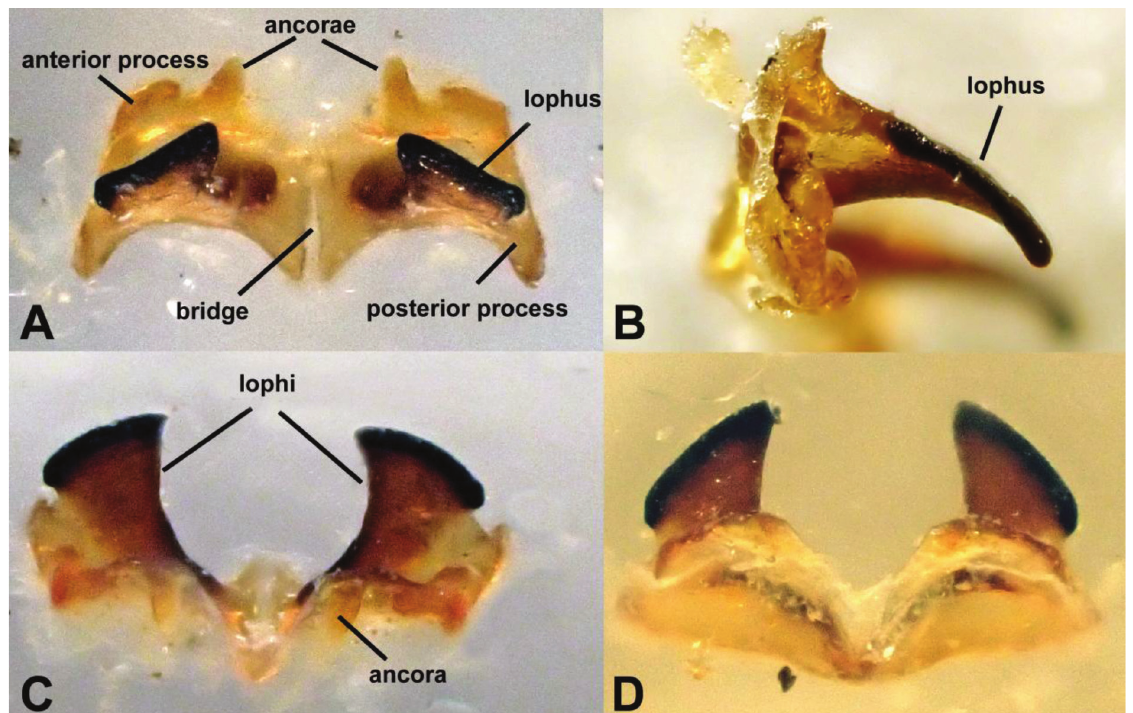
Fig. 5. Epiphallus of male Physocrobylus venetus sp. nov. A. Dorsal view; B. Lateral view; C. Anterior axial view as epiphallus is situated when looking at opened apex of animal; and D. Posterior axial